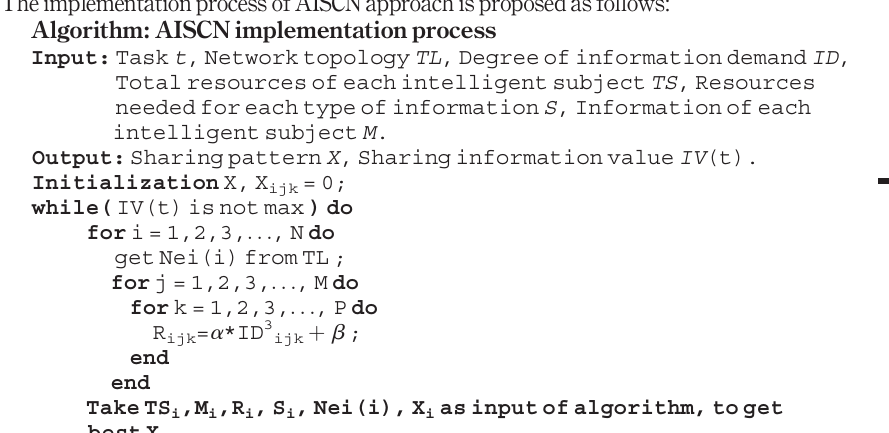
Algorithm: AISCN implementation